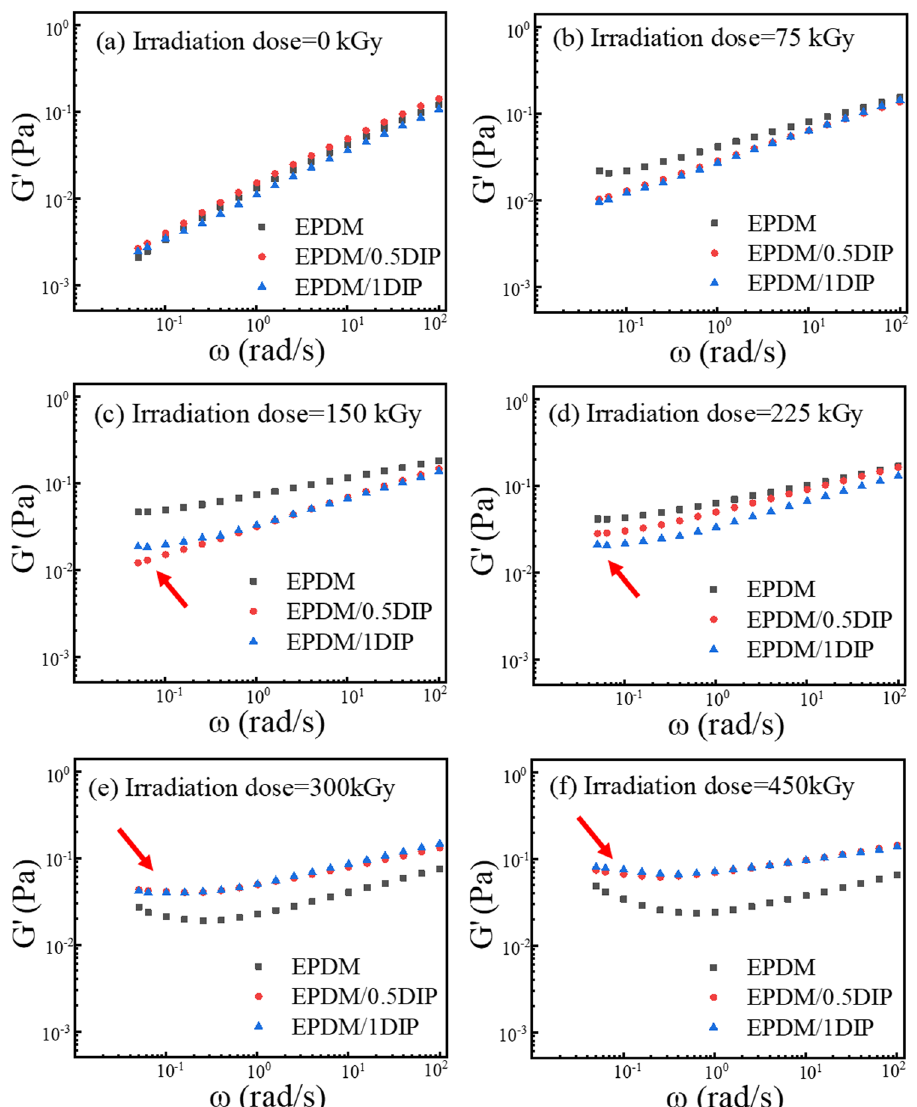
Fig. 7 G ′ of the samples with different blend compositions at different γ -irradiation doses measured in air at 180 °C. a 0 kGy, b 75 kGy, c 150 kGy, d 225 kGy, e 300 kGy, f 450